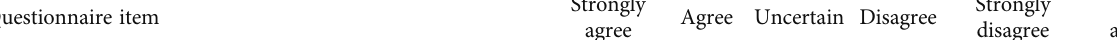
Strongly Agree Uncertain Disagree agree